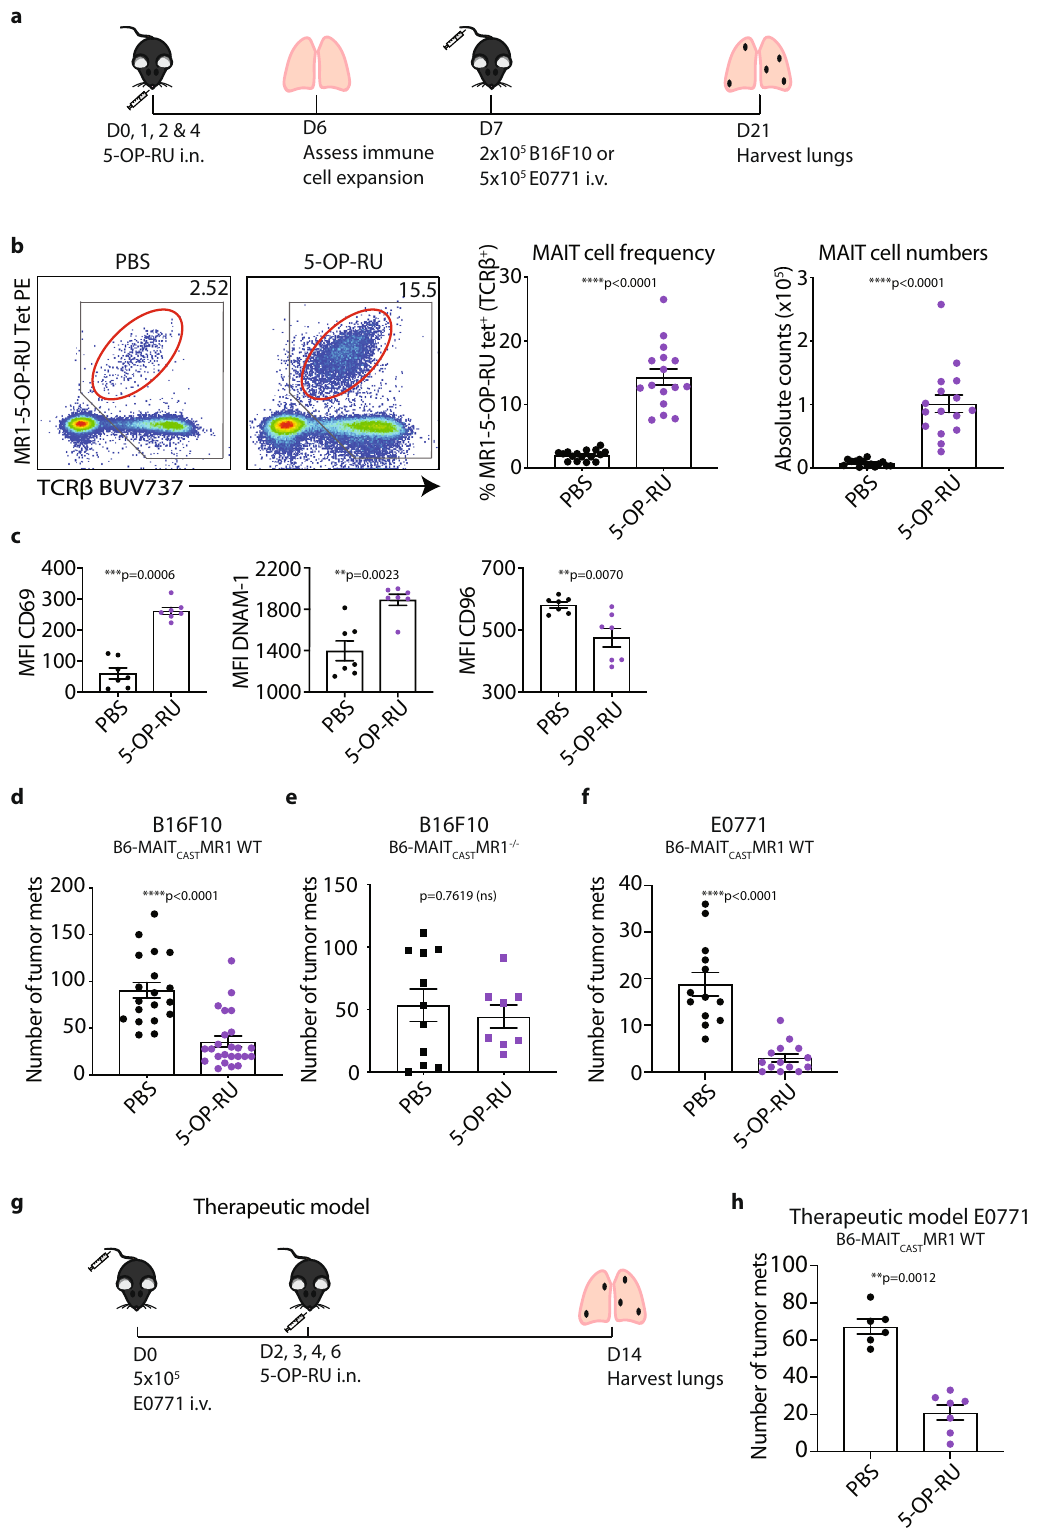
production from MAIT cells (Fig. 5c), and this was observed at similar levels in all MAIT cell subsets (Supplementary Fig. 4d). By contrast, cytokine production from conventional CD4 + and CD8 + T cells was minimal after treatment with 5-OP-RU (Supplementary Fig. 4e). We next assessed the effect of IFN- γ blockade on